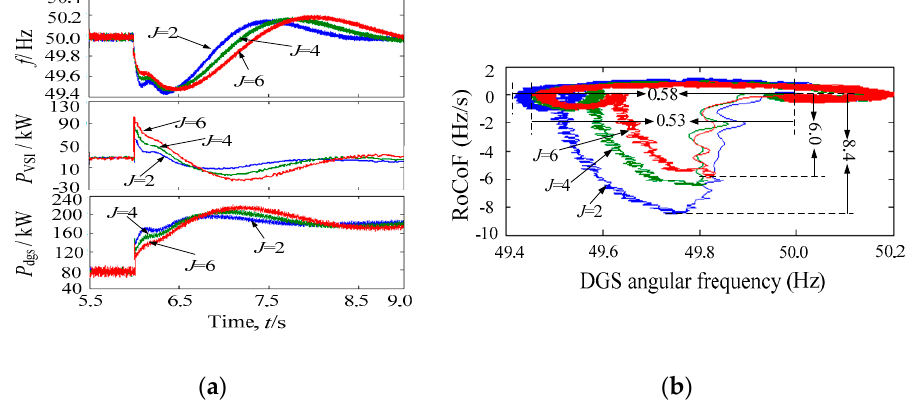
Figure 17. ( a ) Experimental results of the different values of virtual inertia and zero virtual damping on an active power transient; ( b ) Angular frequency-acceleration curves of DGS with virtual inertia control loop.